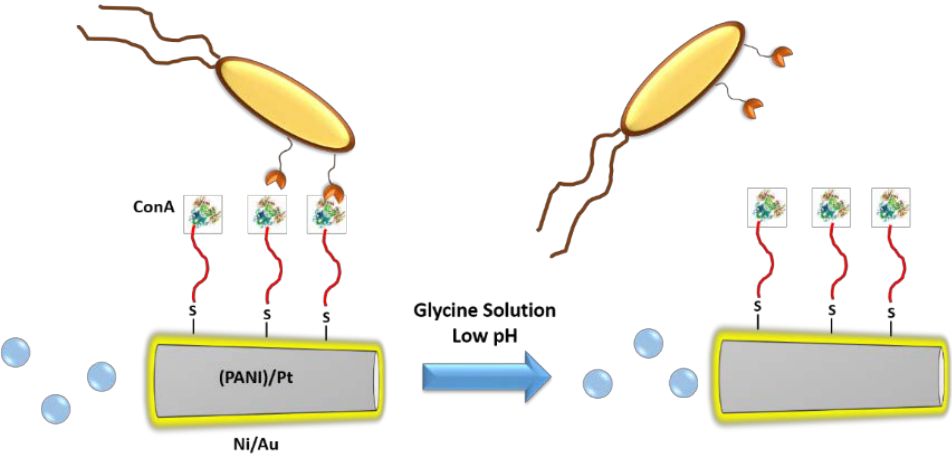
Figure 4. Bacteria capture and release by lectin-functionalized microrockets.